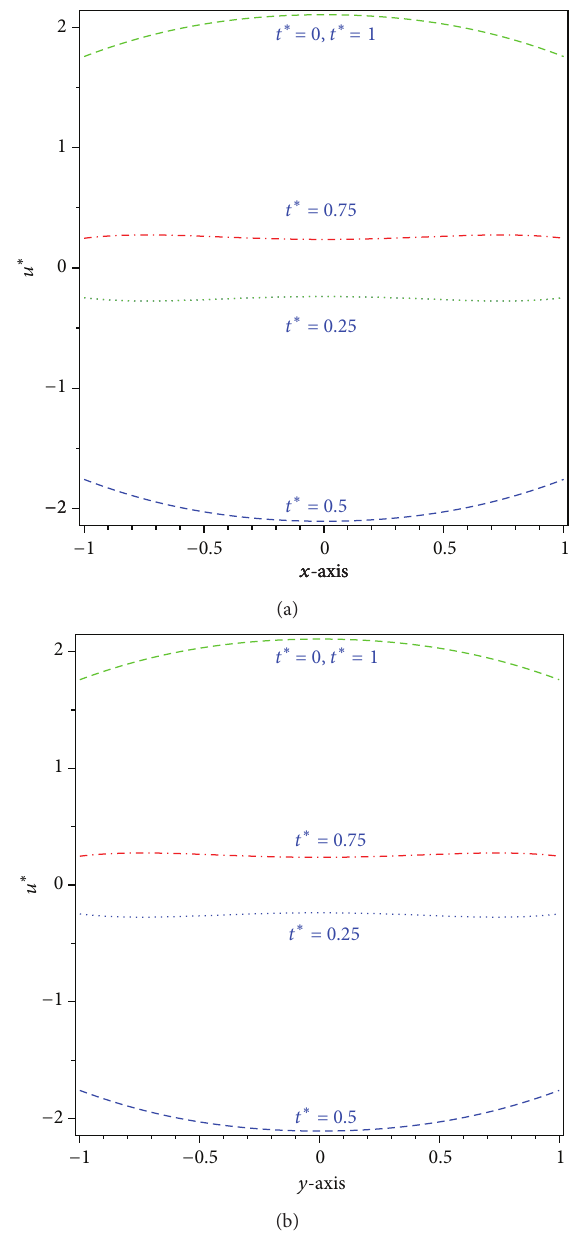
Figure 7: Axial velocity along the 𝑥 -axis and 𝑦 -axis on the cross- section of the channel with the area of 1.0 × 10 −6 m 2 and ratio 𝑏/𝑎 = 1 under the frequency 𝜔 = 𝛼/𝜌𝑎 2 with 𝛼 = 0.005 and slip length of 0.001 at various instants of